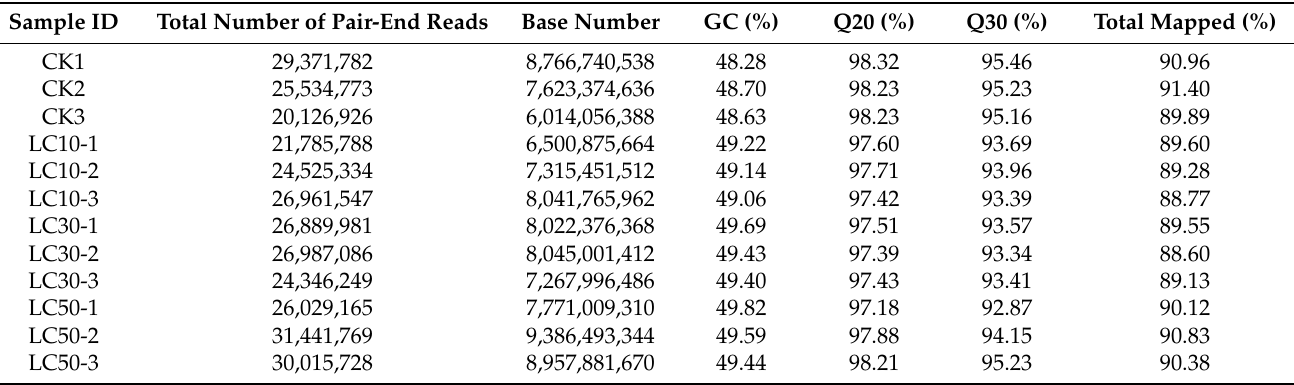
Table 1. RNA-seq data evaluation statistics table.